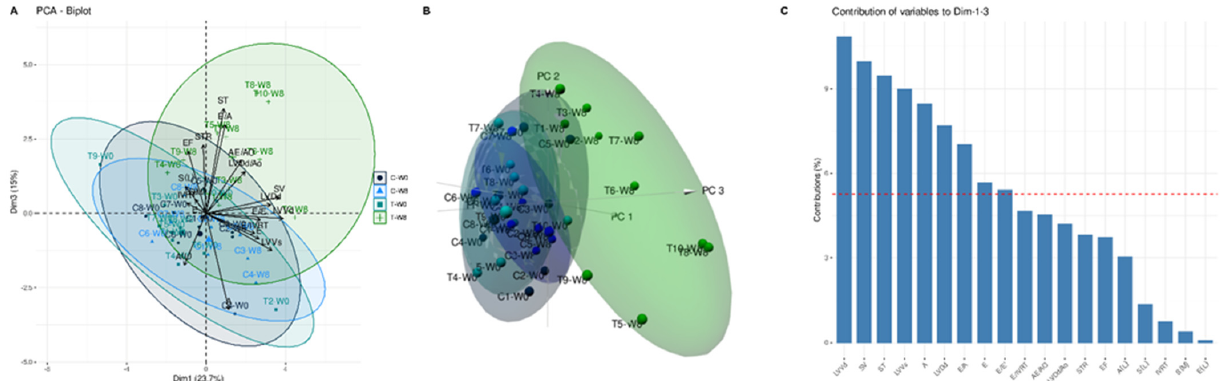
Figure 5. Changes in myocardial deformation ( A ) Strain and ( B ) strain rate of the left ventricle in dogs after 8 weeks of physical training. *: Difference from week zero (W0); ( p < 0.05).